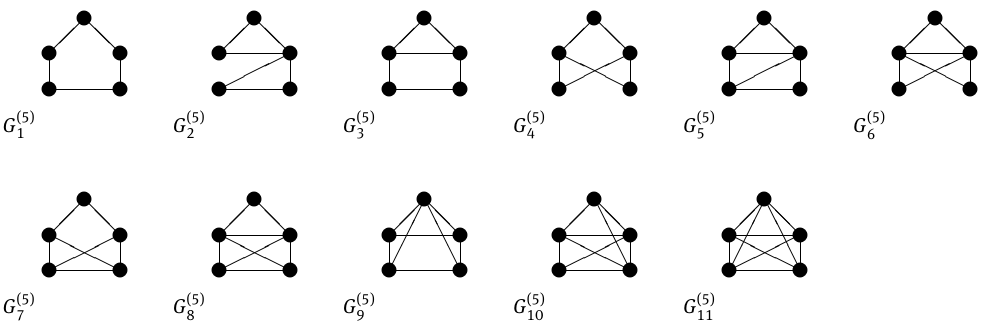
Figure 6.1: The five-vertex graphs each of whose vertex satisfies deg ≥ 2